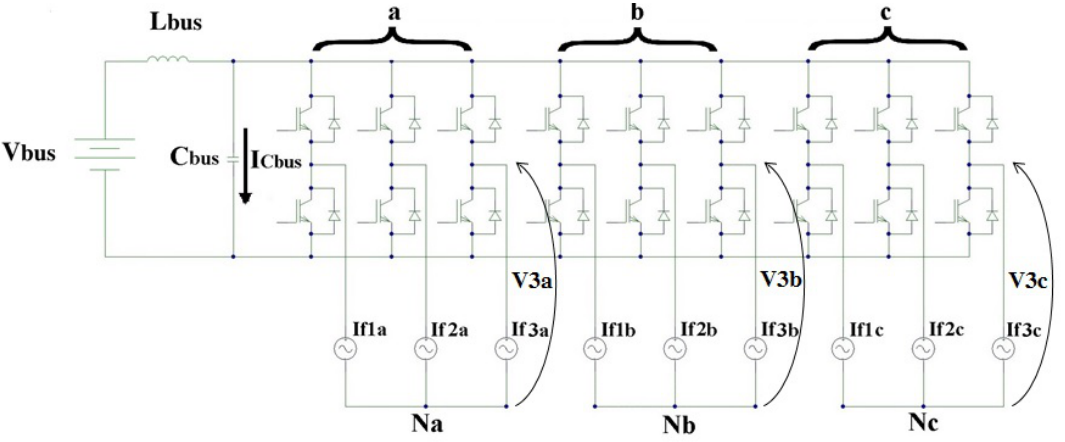
Figure 4. Triple-3-phase converter IGBT (Insulated Gate Bipolar Transistor) based. The converter is obtained from the composition of three 3-phase converter modules. Each 3-phase converter ( a , b , c ) supplies a 3-phase star of the